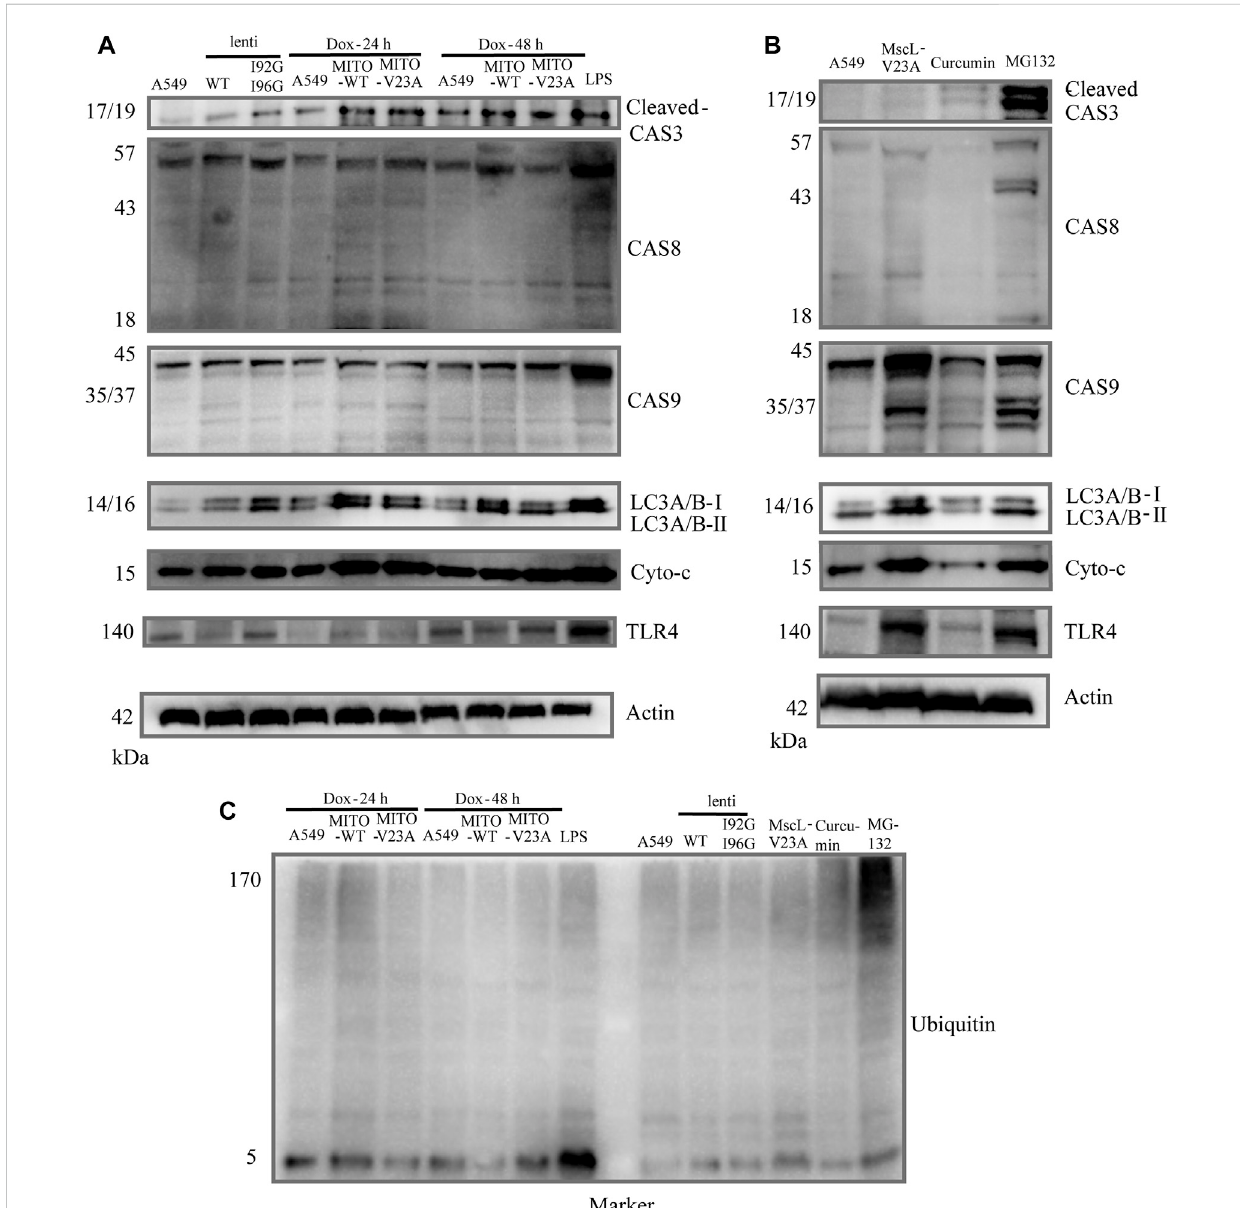
Molecular mechanism of cytoplasmic vacuolization. (A) Cell lysates from doxycycline-induced MITO-MscL expressing A549 cells were analyzed by immunoblotting with the annotated antibodies. (B) Cell lysates from different types of cytoplasmic vacuolization were analyzed by immunoblotting with the annotated antibodies. (C) Western blot analysis of ubiquitin. LPS (1 μ g/mL, 12 h), Curcumin (40 μ M, 12 h), MG-132 (25 μ M, 16